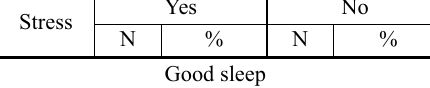
Absolute and relative frequency (%) of stress based on the assertion of sleeping well or